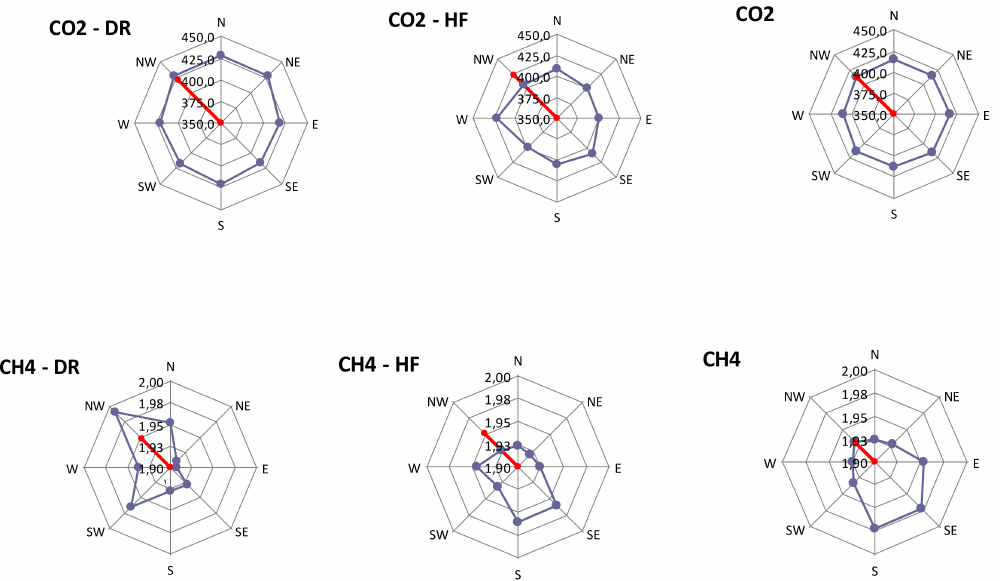
Figure A4. Average levels of CO 2 and CH 4 vs. wind direction measured at the Stary Wiec sta- tion during drilling (DR), hydrofracturing (HF), and for the remaining period of measurements. Concentrations units for CO 2 and CH 4 are parts per million (ppm).